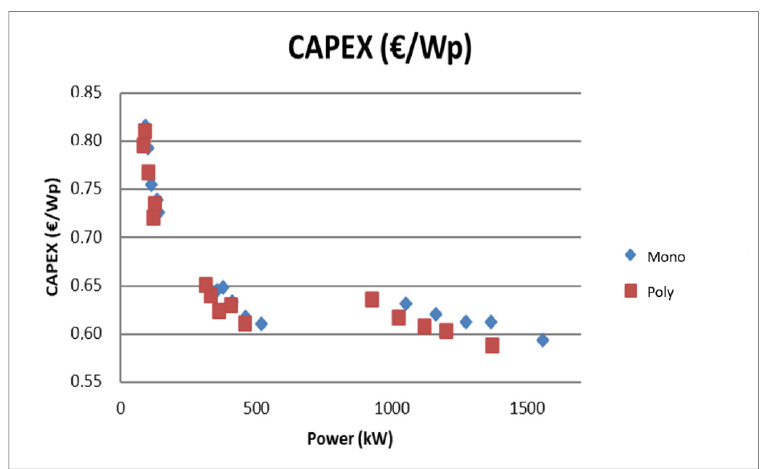
Figure 11. Normalized CAPEX as a function of installed capacity.